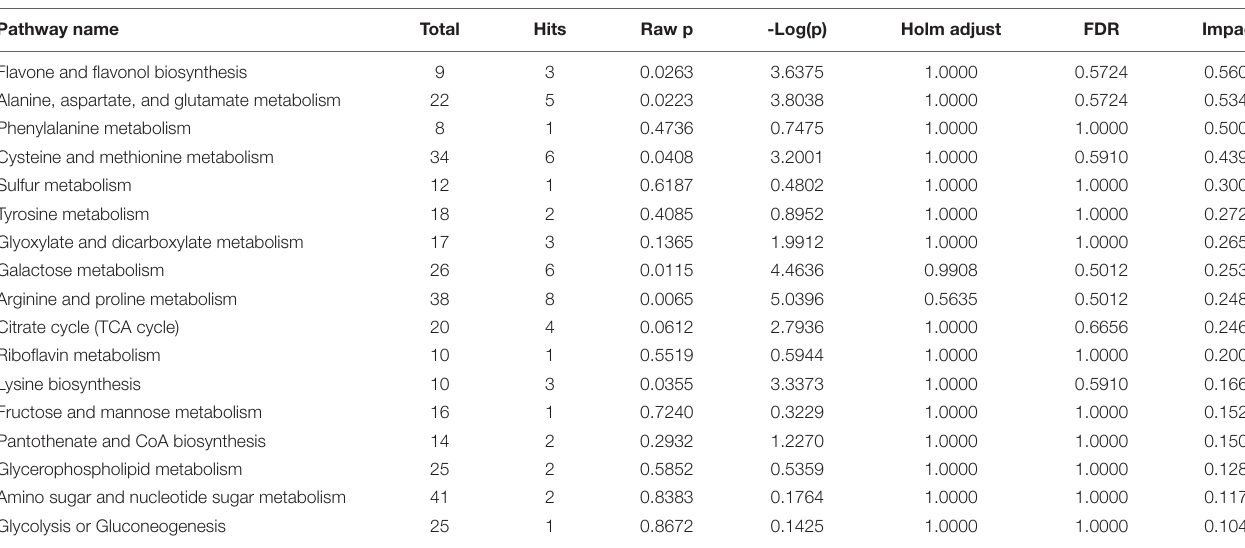
FIGURE 6 | Analysis of differentially expressed metabolites (DEMs) and KEGG pathway. (A) DEMs identified between the red- and blue-light treatments; (B) Analysis of KEGG pathway of DEMs. TABLE 1 | Results from KEGG pathway